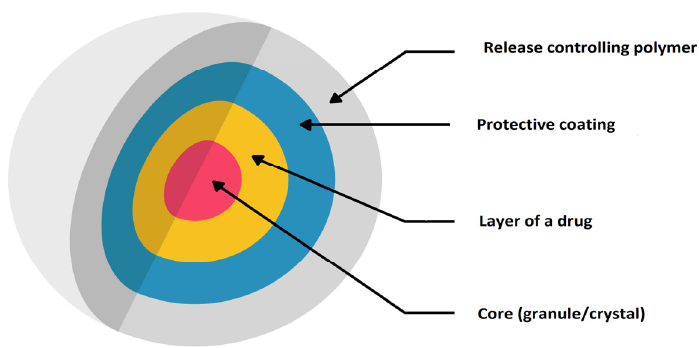
Figure 8. Scheme illustration of Diffucaps ® bead technology modified from Weil [106].